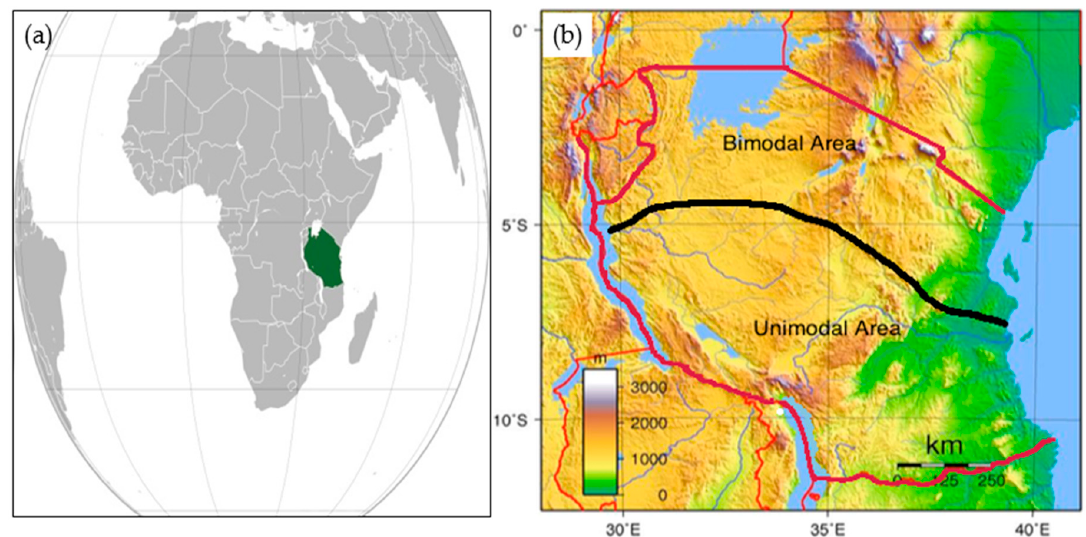
Figure 1. Location of Tanzania in Africa (Image source: citiesandplaces.com) ( a ) and the rainfall zone in Tanzania ( b ).